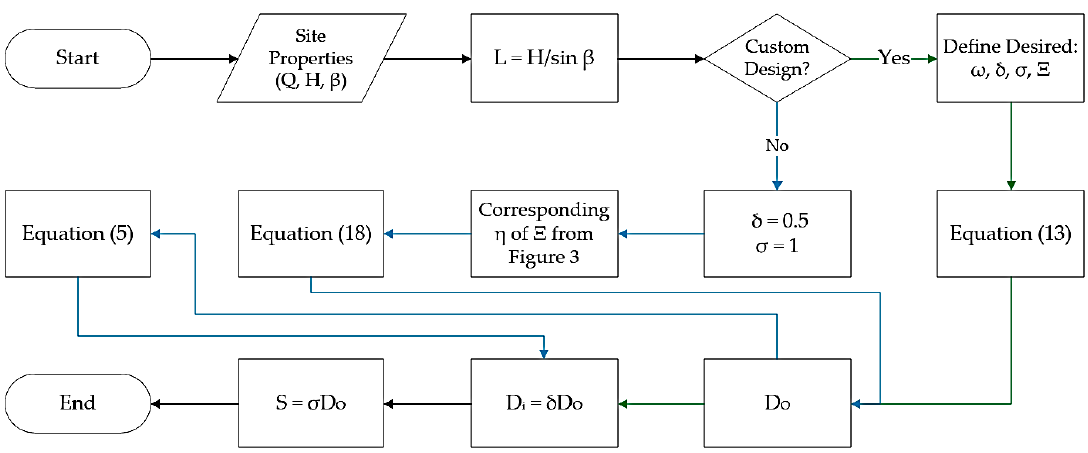
Figure 6. A fast and easy analytical method for designing Archimedes screws.